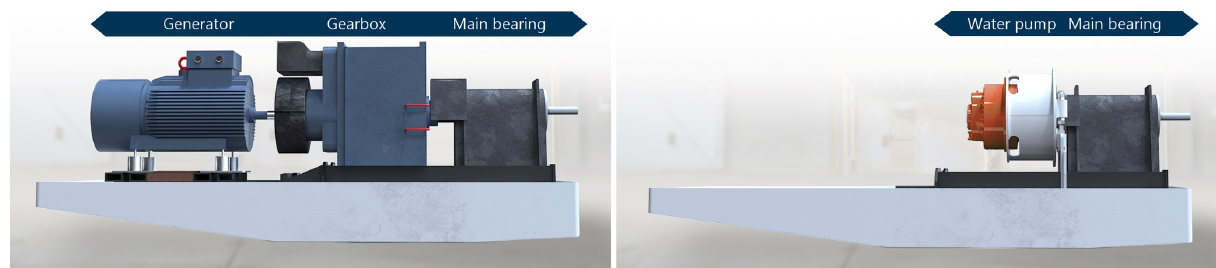
Figure 2. The high power-to-weight ratio of the hydraulic components and the possibility to abandon power electronics from the nacelle make the advantages of mass and space reductions in the nacelle